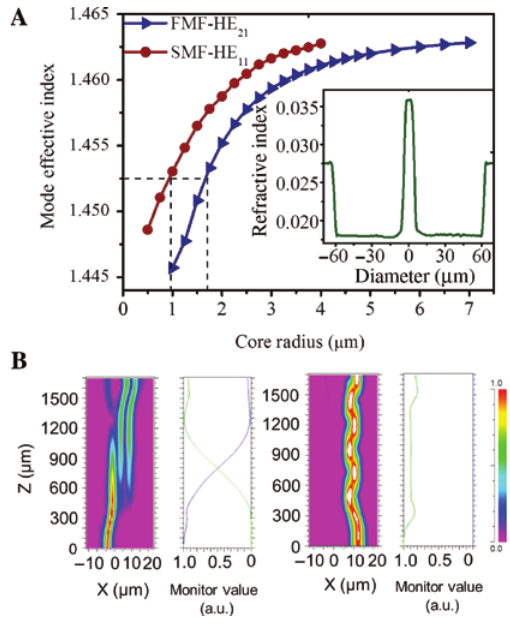
Figure 2: The numerical calculation and simulation of phase matching condition. (A) The mode effective index curves for the LP and LP modes vs. 01 11 core radius at the wavelength of 660 nm. Inset: refractive-index distribution of the few-mode fiber (FMF). (B) Power exchanging curves in the coupling region. LP mode is lunched in the input 01 single mode fiber (SMF) port (left) and input FMF port (right), the blue and green lines show the power of SMF and FMF,